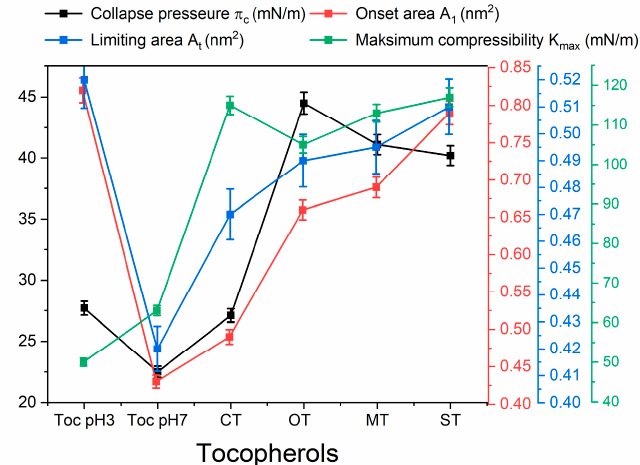
Figure 7. Parameters, given in the legend, calculated from isotherms presented in Figure 2. Error bars are SD calculated for three different repetitions.